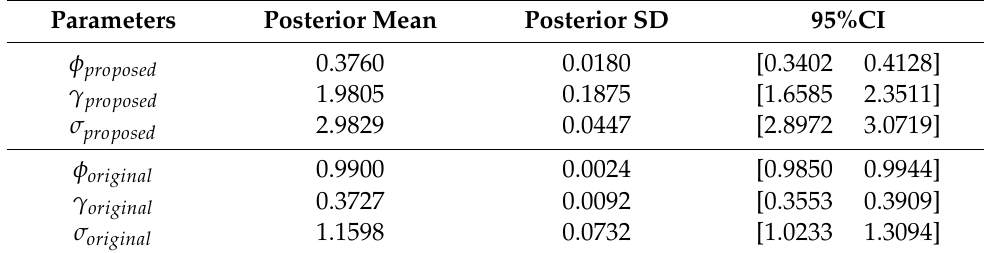
Table 38. Comparison of estimated parameters (4 January 2016, JAL, Tokyo, Japan).